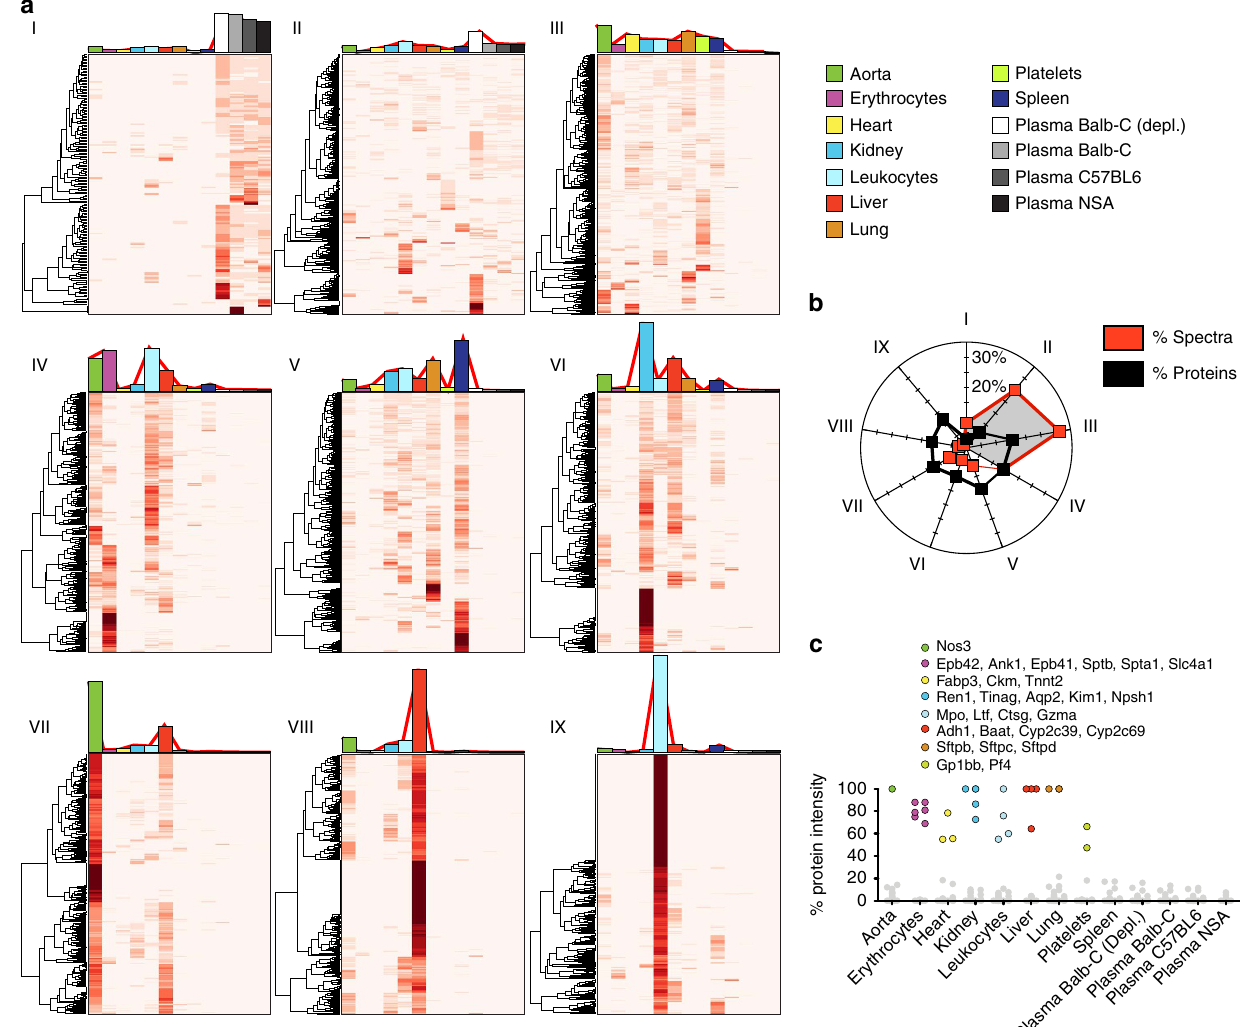
Figure 2 | Protein function enrichment of the tissue-specific protein abundance atlas. ( a , b ) The quantitative protein profiles across the analysed organs and cells were subdivided into nine expression profiles using k-mean clustering and visualized as heat maps (I–IX). The average quantitative distribution of the proteins within one cluster is shown as coloured bar plots on top of the individual heat maps. The colours indicate organ, plasma or cell type. The total intensity of the proteins within the individual cluster was summed and total distribution between clusters are shown in b . ( c ) Examples of identified proteins with high tissue specificity, coloured according to the legend. The corresponding protein intensity in the other organs and cells are made grey for clarity. Data are based on scaled spectral counts from LC-MS/MS